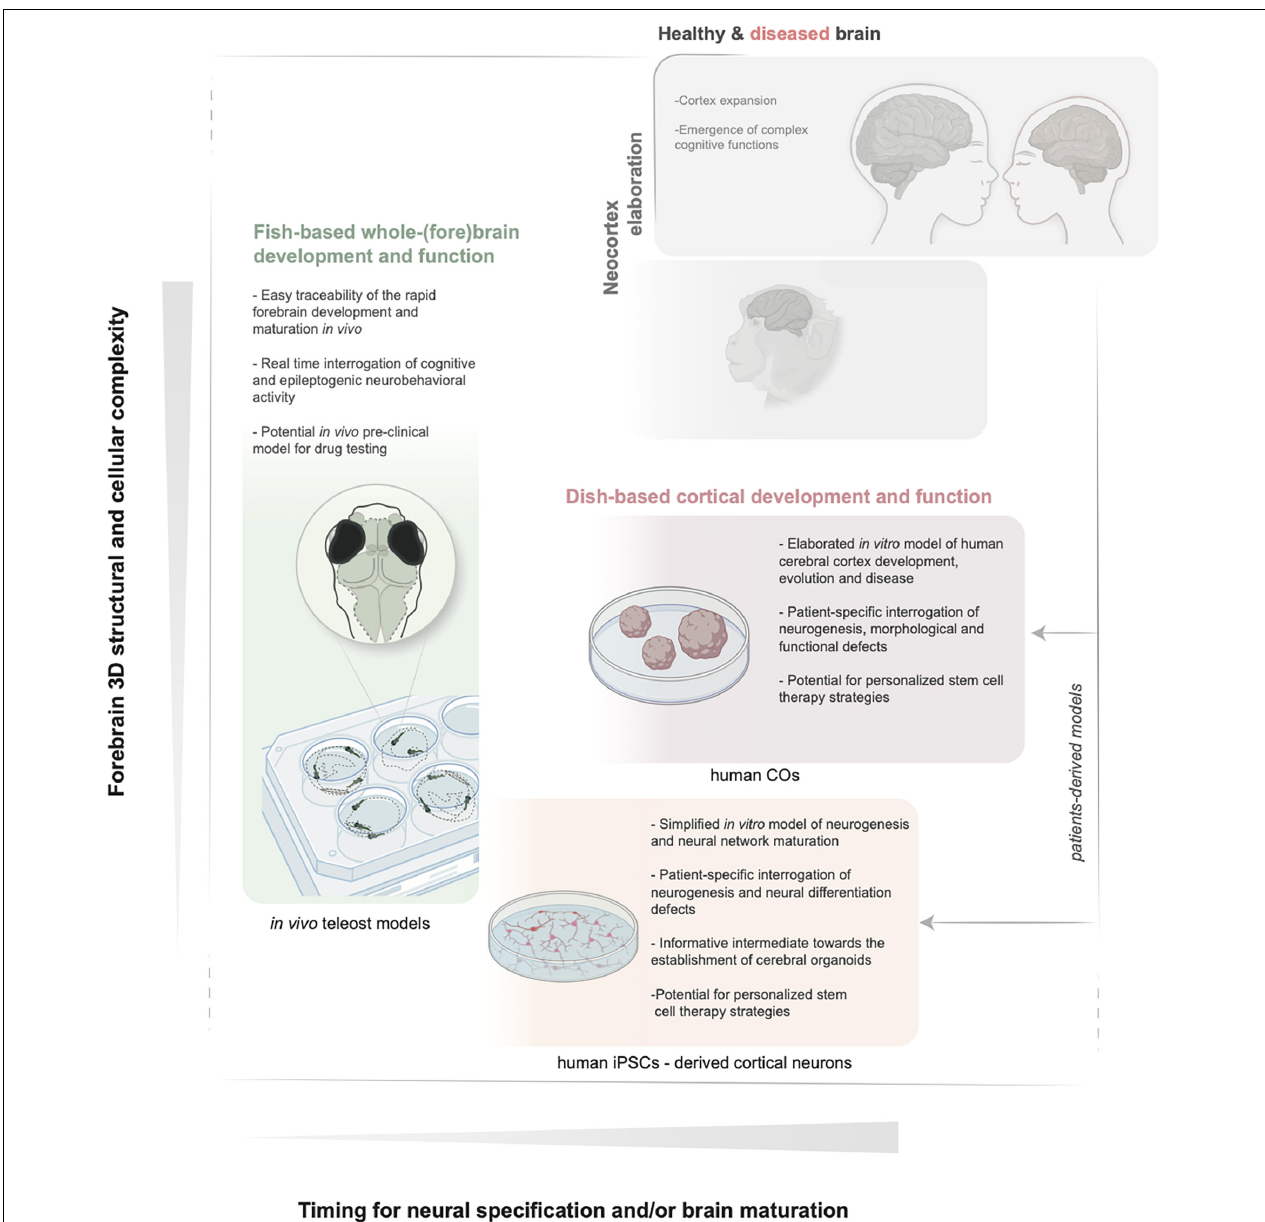
FIGURE 1 | Schematic illustration of the key features of in vivo zebrafish and in vitro iPSCs and COs models. The relative increase in structural and functional complexity of the forebrain and the timing to obtain mature neuronal populations are indicated by the y and x axes, respectively. BioRender (BioRender.com) and Illustrator (Adobe) were used to generate the illustration. iPSCs, induced pluripotent stem cells; COs, cerebral